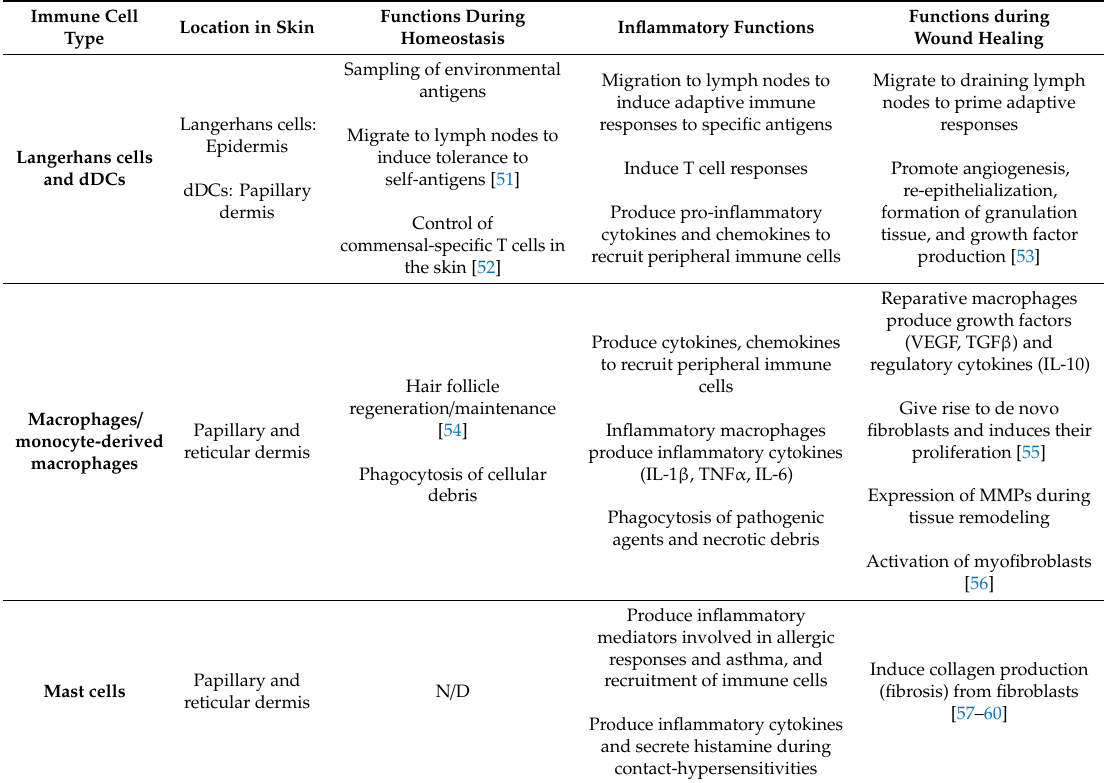
Table 1. Summary of the skin’s immune cells. The location of each immune cell type in the skin tissue and their functions during homeostasis, inflammation, and wound healing are described. N / D: not